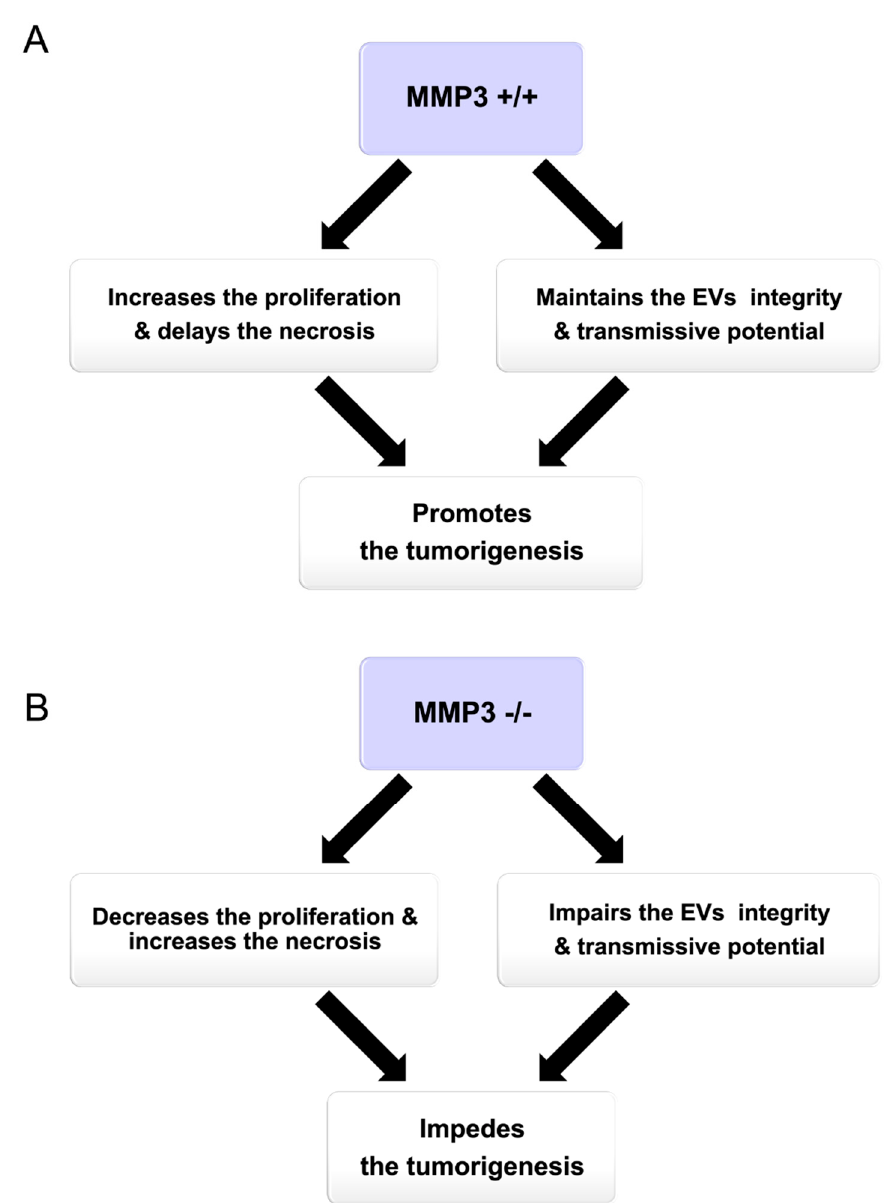
Figure 13. Graphical abstract summarizing the role of MMP3 on tumorigenesis in vitro. ( A ) Illustrating the net results of the presence and ( B ) absence of MMP3 protein.